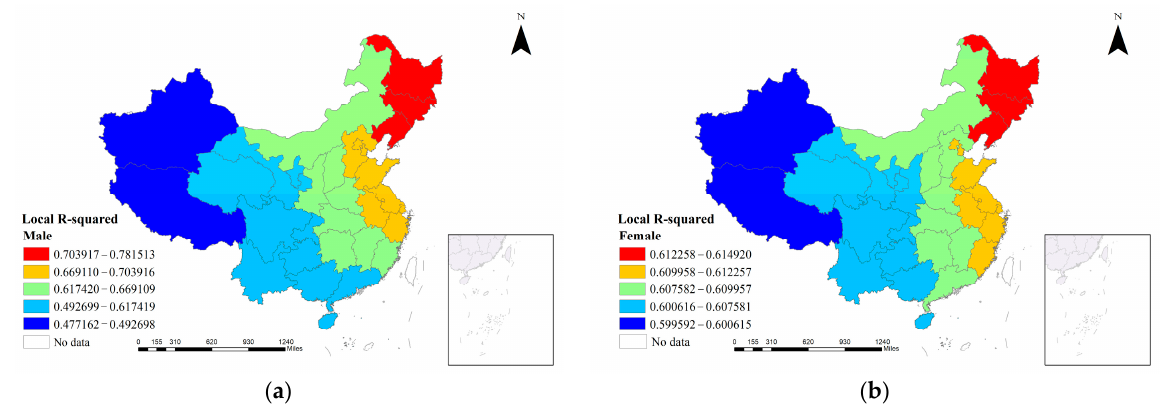
Figure 2. Spatial patterns of local R-squared in the MGWR. ( a ) Local R-squared spatial patterns of the male group in China, ( b ) local R-squared spatial patterns of the female group in China.